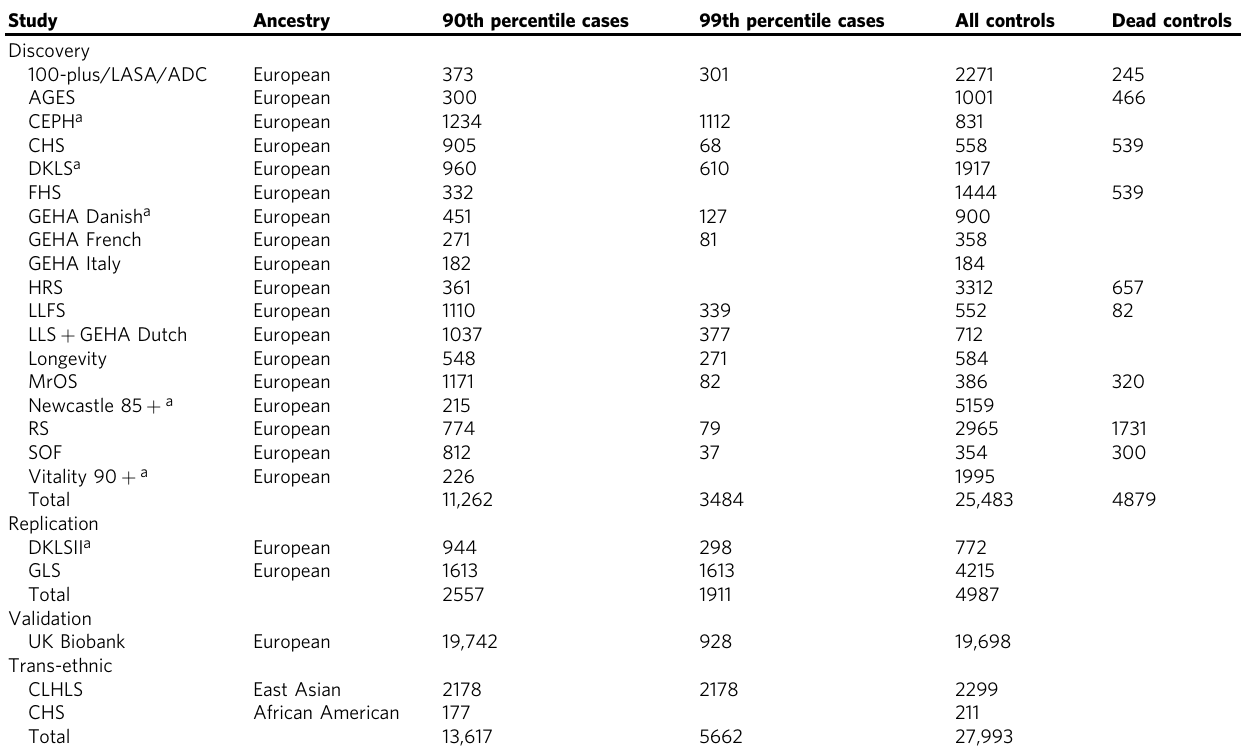
Table 1 Samples included in the different genome-wide association meta-analyses or the replication and validation Study Discovery 100-plus/LASA/ADC